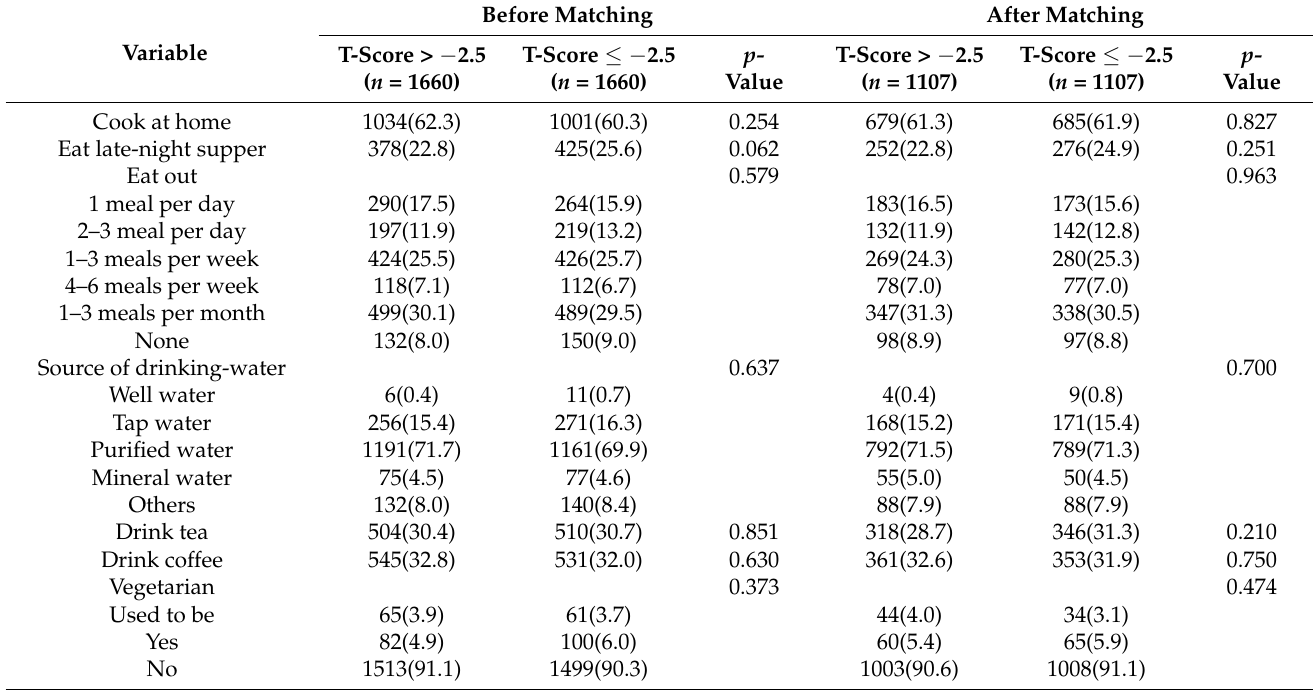
Table 4. Dietary habits, healthy behavior, and healthcare